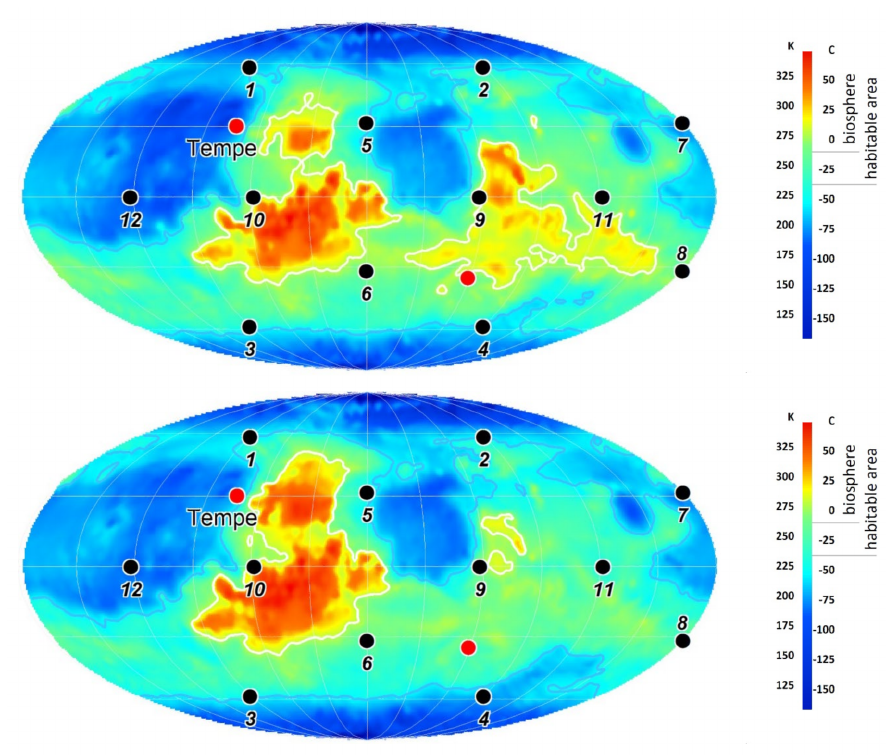
Figure 19. Tempe: 100 GT “asteroid” ( top ); 1.5 MT “factory” ( bottom ) (after 100 Martian years).